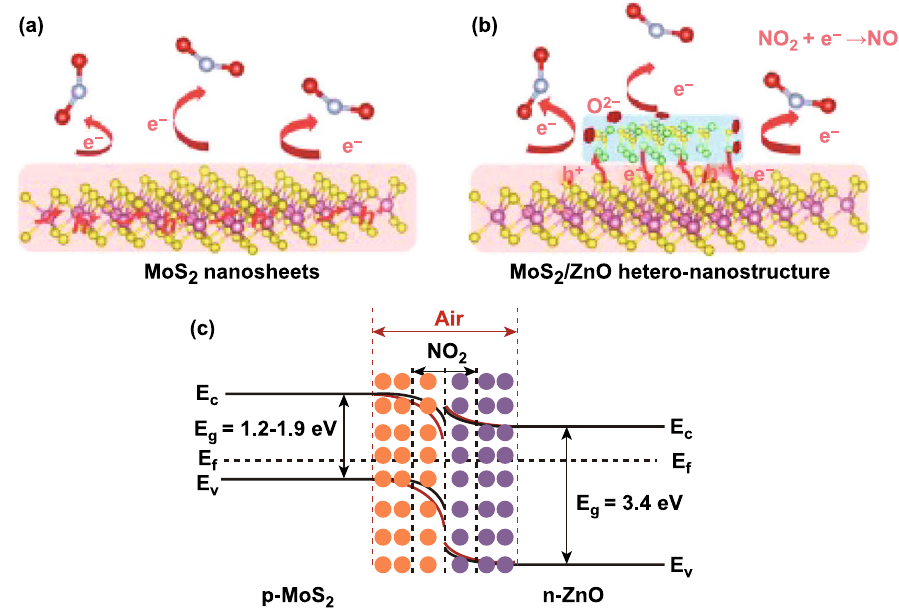
Fig. 22 Schematic of sensing mechanism of a pure MoS 2 nanosheets and b hybrid mechanism. c Band diagram of hybrid 2D/0D heterojunction gas sensor in air ambient and in the NO 2 ambient. Reproduced with permission from Ref. [347]. Copyright (2015) American Chemical